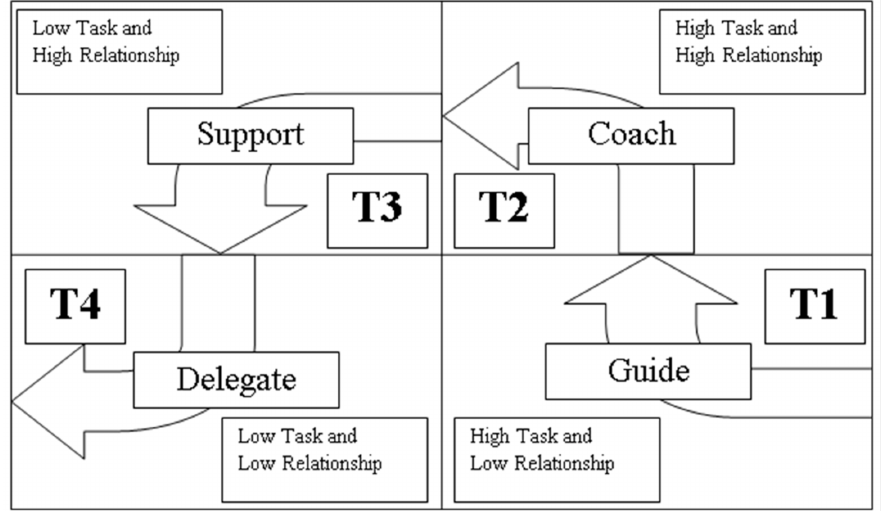
Figure 1. Situational leadership, after Hersey et al. (1982)